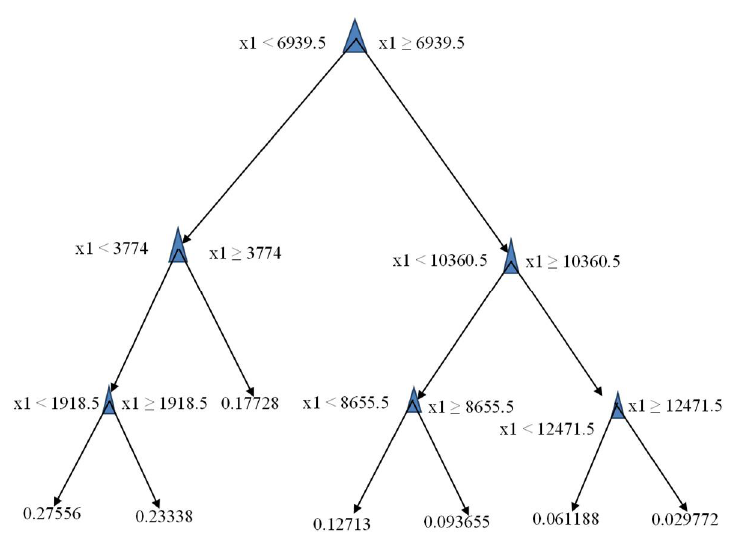
Figure 2. Pruned tree.